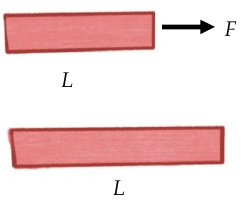
Figure 3. Strain illustrated.